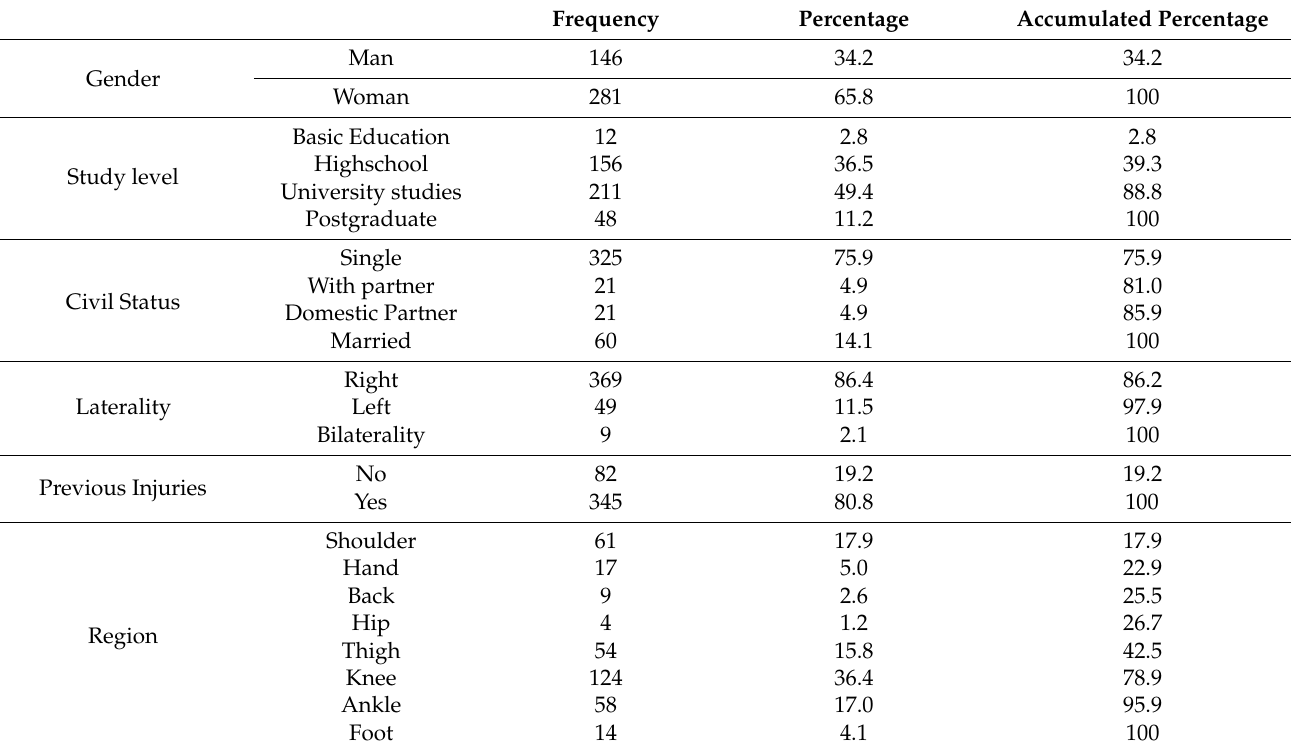
Table 1. Descriptive characteristics of the sample in variables that can be analysed according to the frequency of